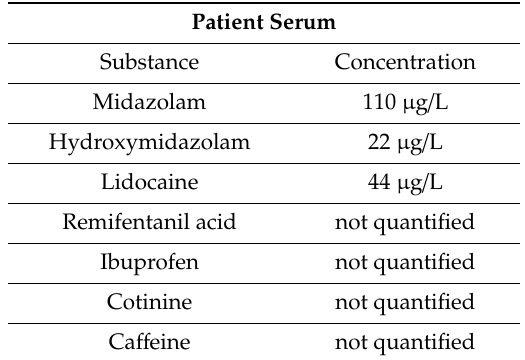
Table 5. Substances detected in serum of case 2, obtained on day 2 of hospitalisation.